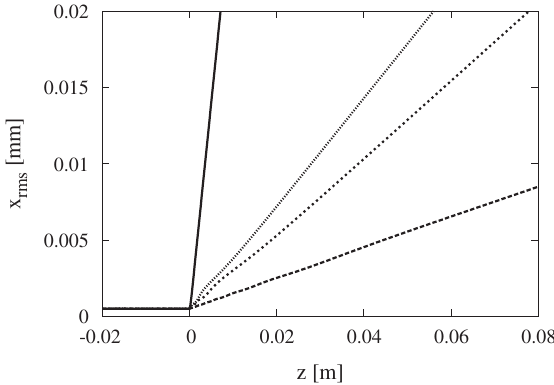
FIG. 2. Development of the beam size behind a plasma channel for g ¼ 200 m − 1 (smallest divergence), 500 m − 1 , 700 m − 1 and the free space solution (largest divergence). The constant focus- ing channel ends at z ¼ 0